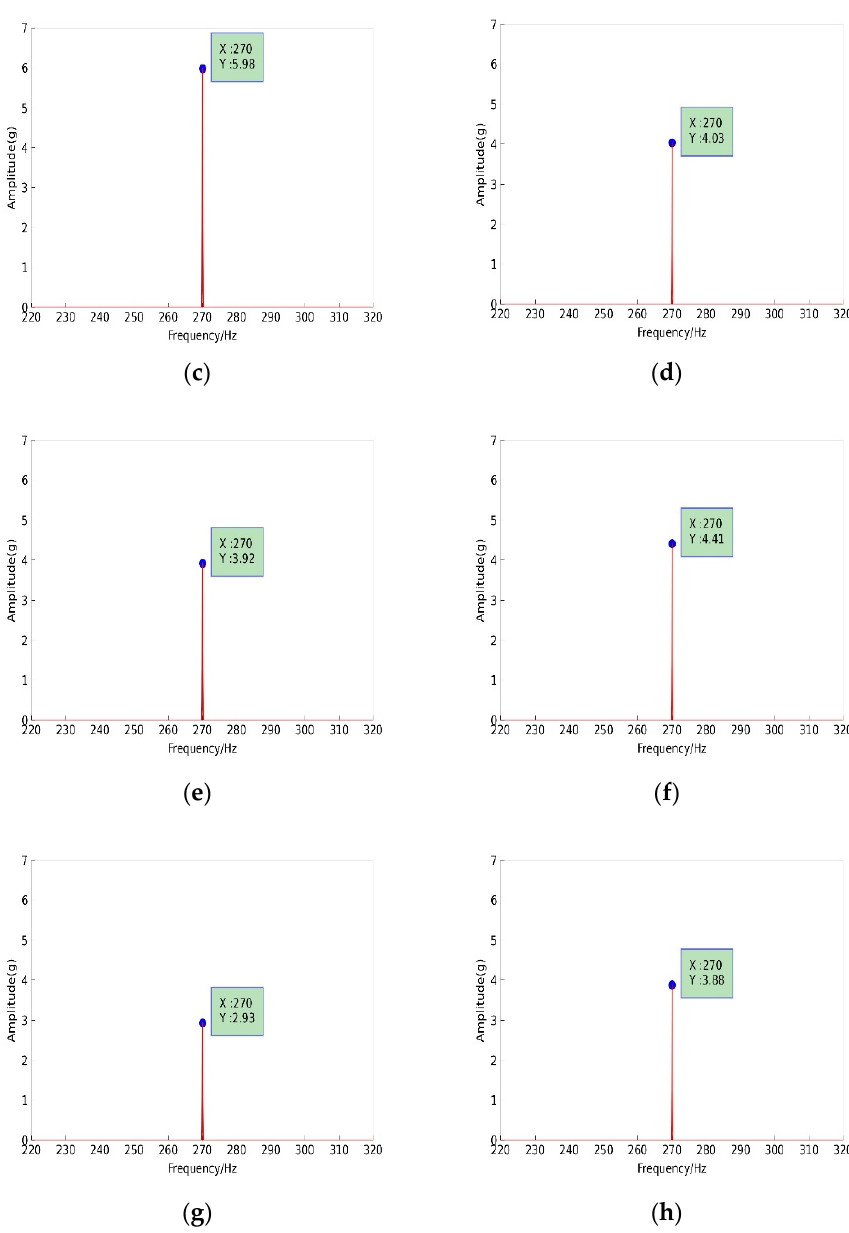
Figure 12. Vibration response under high-pressure constant-frequency excitation: ( a ) TA18 tita- nium alloy pipeline; ( b ) Nitronic40 stainless-steel pipeline; ( c ) 6061T6 aluminium alloy pipeline; ( d ) specimen no. 1; ( e ) specimen no. 5; ( f ) specimen no. 7; ( g ) specimen no. 8; ( h ) specimen no.